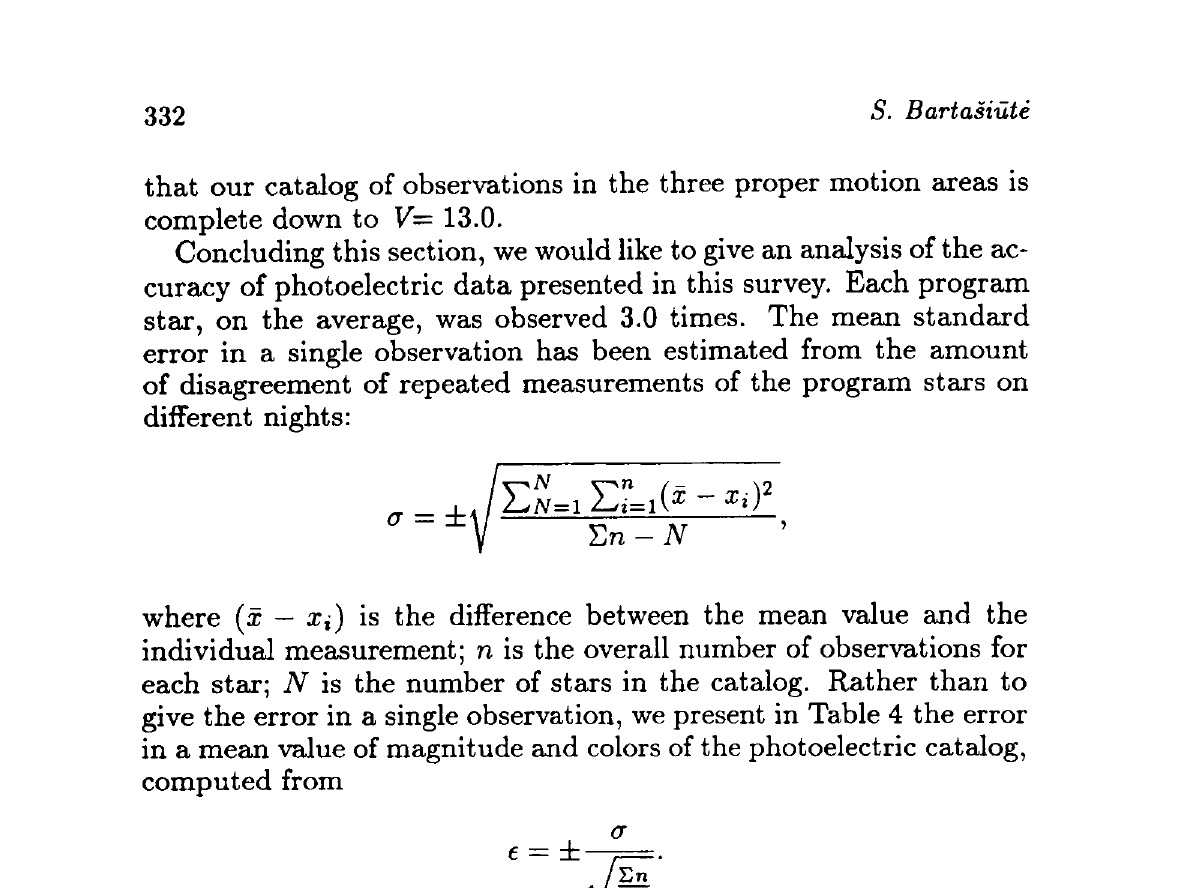
Table 4. Mean errors of the catalog of photoelectric observations V